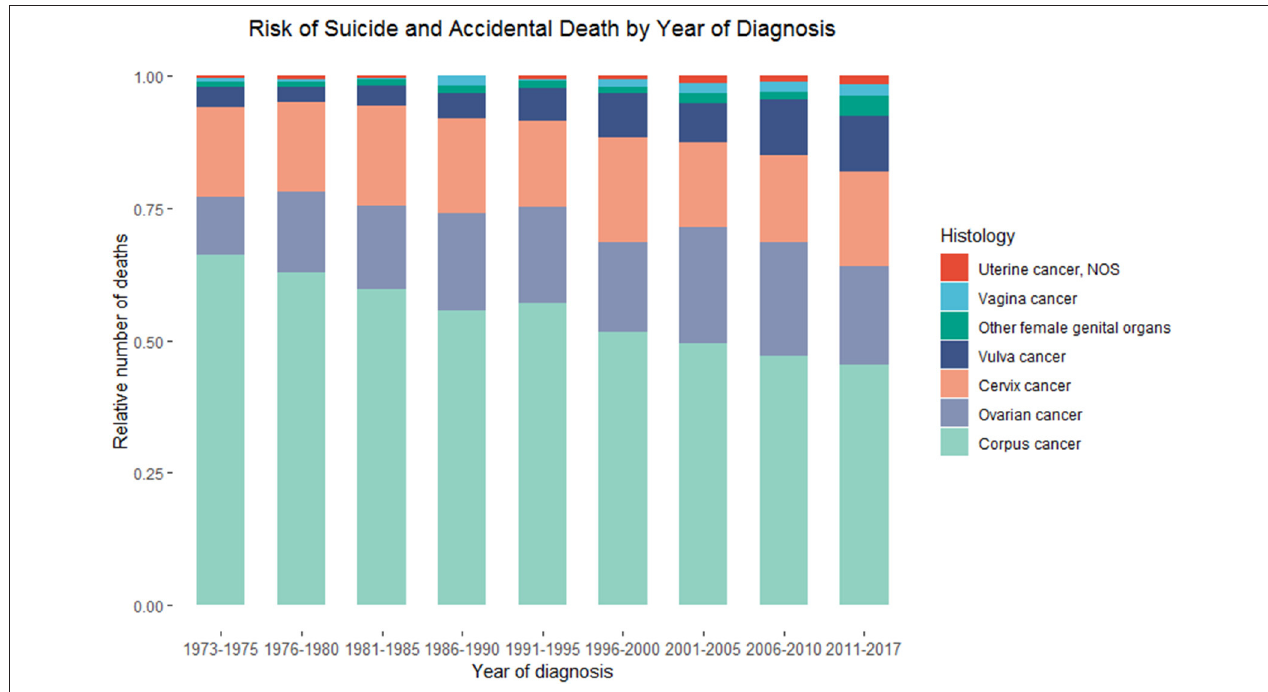
FIGURE 2 | Death due to suicide and accidental injury among patients with primary malignant ovarian cancer in SEER database by calendar year of death.